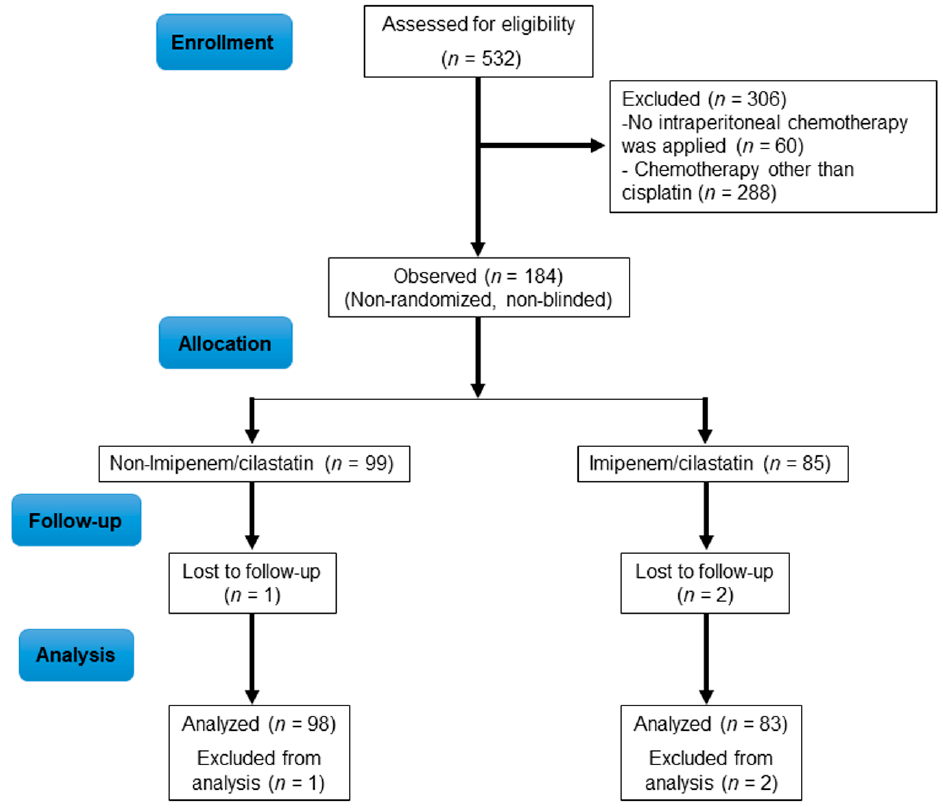
Figure 1. Flowchart of patient enrolment and follow-up.